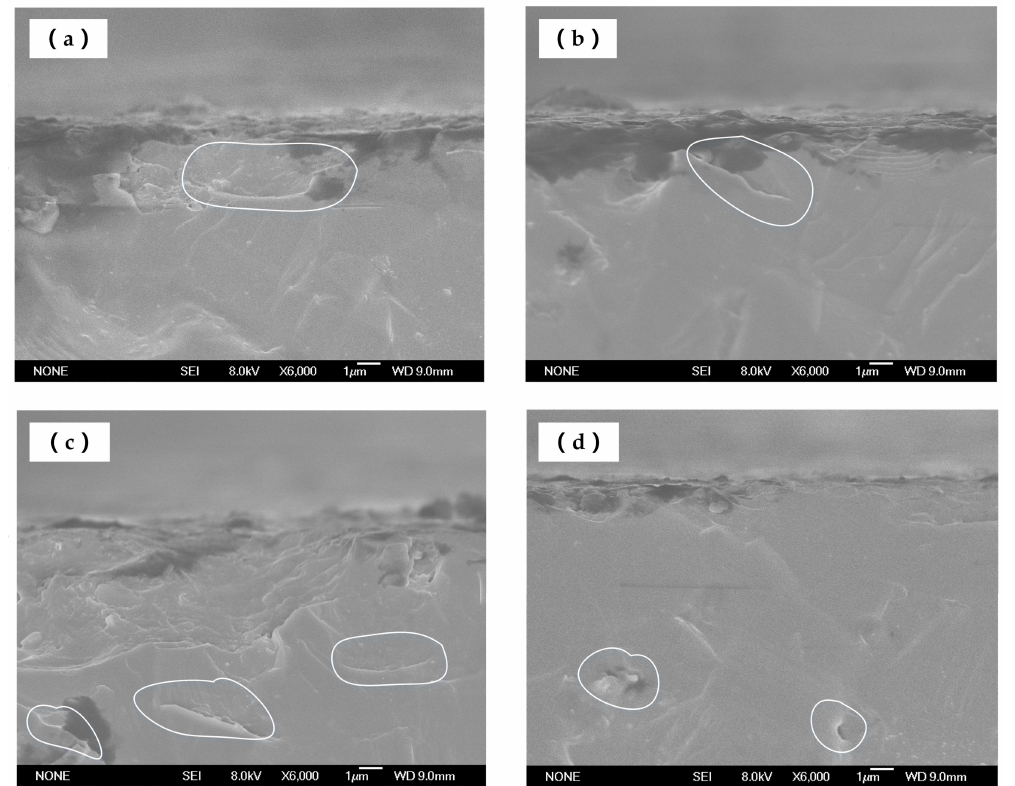
Figure 11. SEM images of SSD morphology of SiC for a p = 3 µ m, V s = 2200 r/min, and W2.5: ( a ) near the finished surface; ( b ) bottom of the pit; ( c ) extended surface; ( d ) far away from the